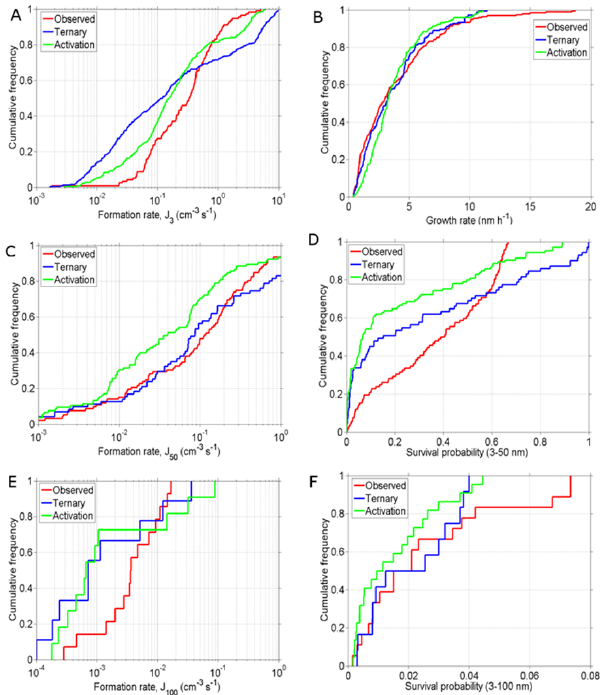
Fig. 5. Cumulative distribution function (CDF) of modeled and measured nucleation metrics at PGH. Twenty-four hour averaged nucleation rate ( J 3 ) is shown in panel (A) , growth rate for event- lengths in panel (B) , 50nm particle formation rate ( J 50 ) in panel (C) , survival probability to 50nm (SP 3 − 50 ) in (D) , 100nm parti- cle formation rate ( J 100 ) in panel (E) , and survival probability to 100nm (SP 3 − 100 ) in panel (F) . Descriptive statistics for these dis- tributions can be found in Tables 2 and